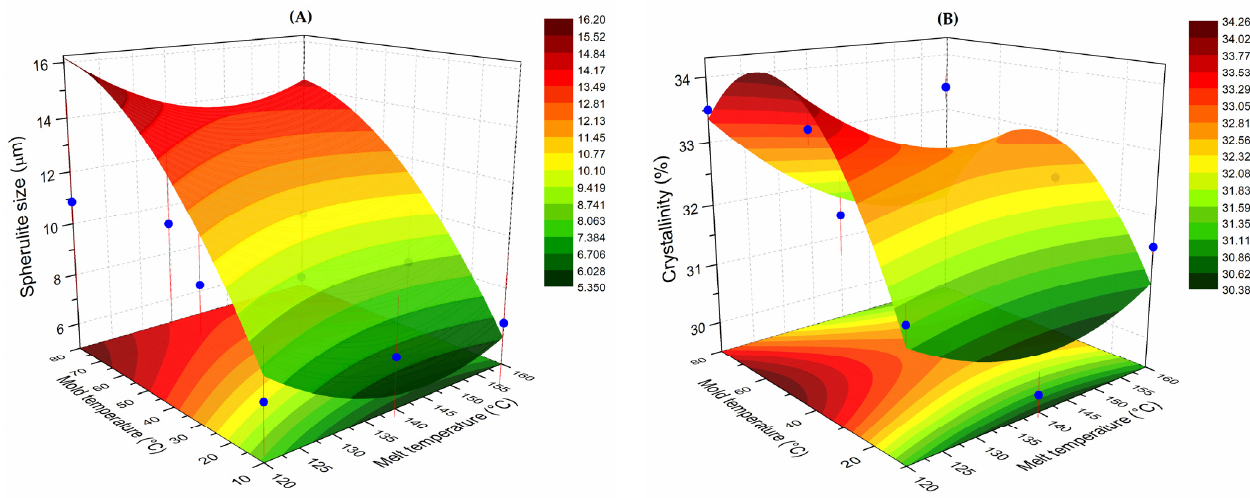
Figure 4. Surface response plots (SRP) for ( A ) spherulite size and ( B )